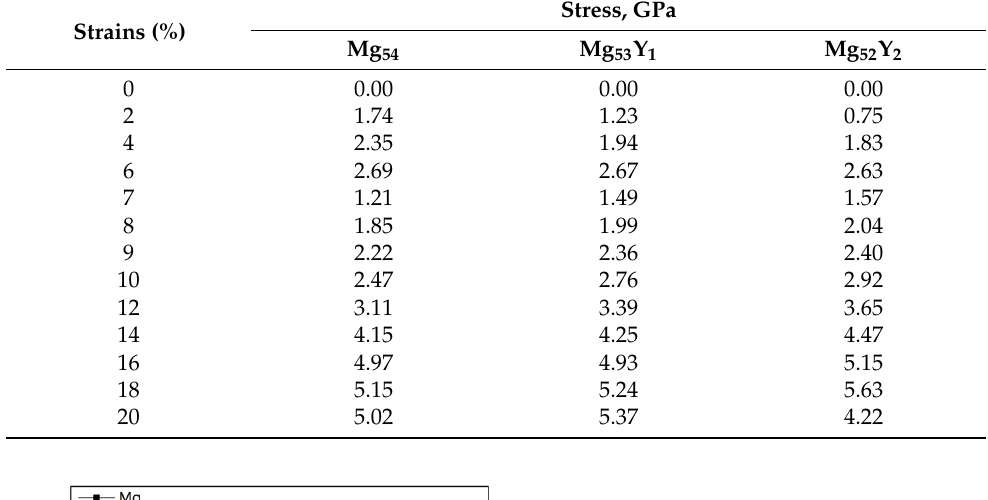
Table 2. The Stress values of Mg 54 , Mg 53 Y 1 , Mg 53 Y 2 under different strains.